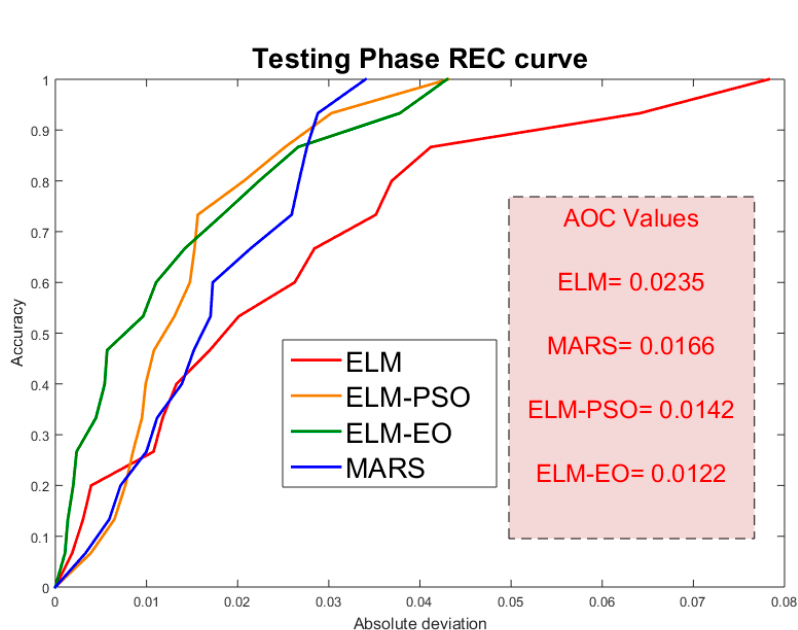
Figure 5. REC curve plot of the simulated models and respective AOC values.